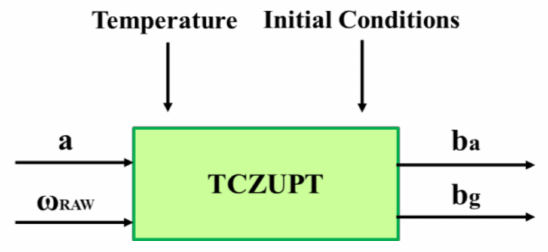
(standard ZUPT filter). ABI